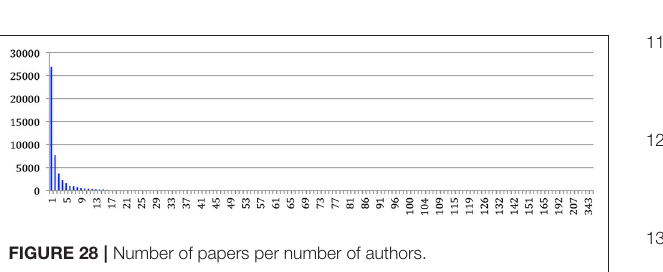
FIGURE 28 | Number of papers per number of authors.